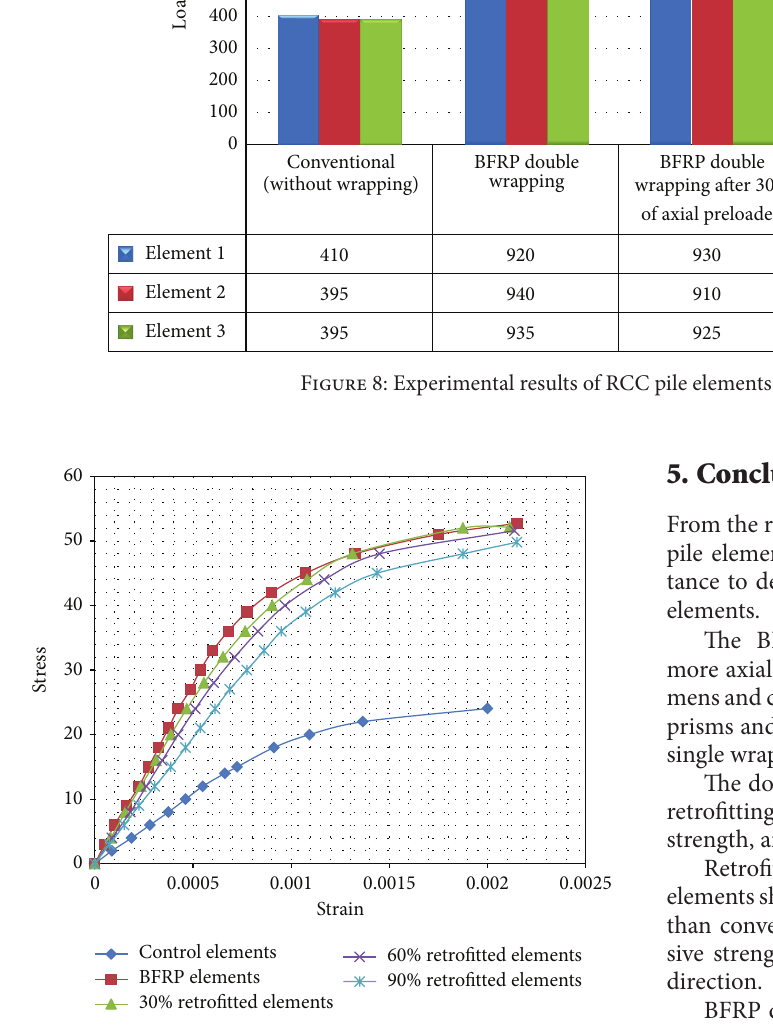
Figure 9: Stress versus Strain Curve for axial compression loaded pile